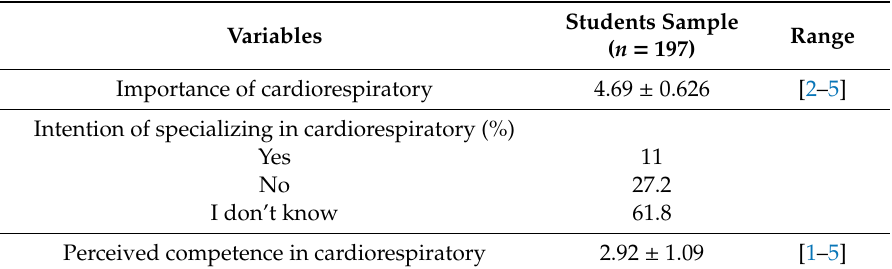
Table 2. Values assigned to competence, importance, and interest in cardiorespiratory physiotherapy of all the students included in the